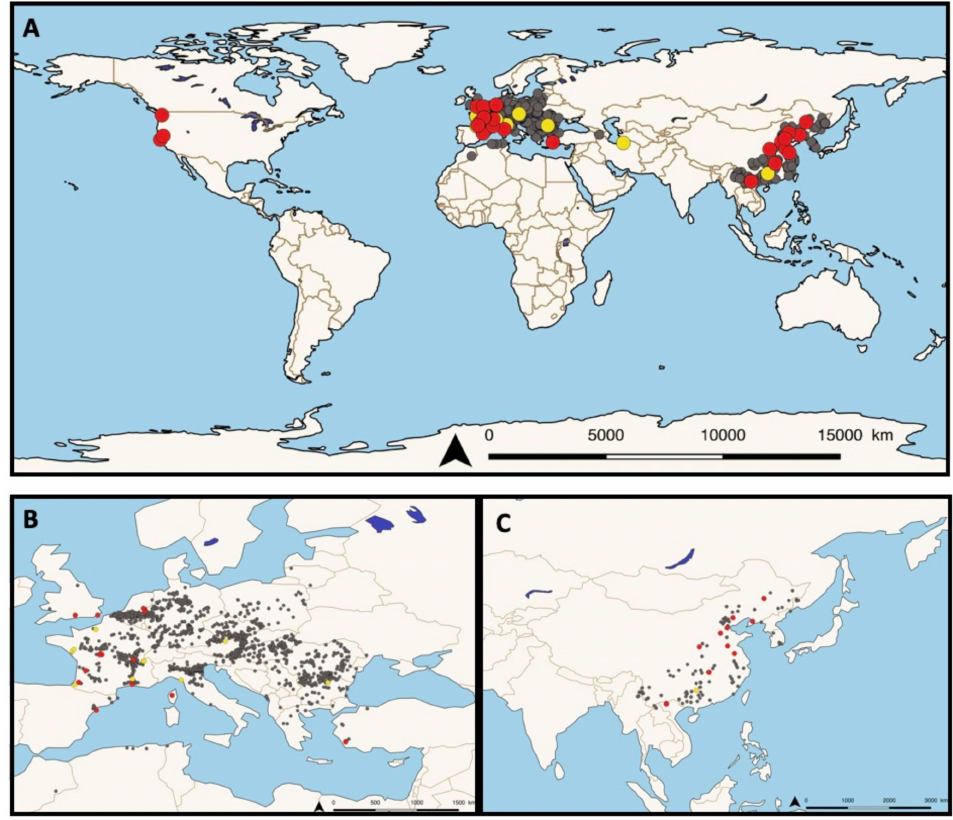
Figure 1. ( A ) Worldwide distribution of the generalist fungal parasite S. destruens . The distribution of the asymptomatic carrier host Pseudorasbora parva in its native (Est Asia) and invasive range is indicated by grey dots. The red and yellow dots indicate the distribution of P. parva and other native species tested for the presence of the agent rosette Sphareothecum destruens DNA; Red dots indicate populations found to be positive to S. destruens DNA and yellow dots indicate non-conclusive results. ( B ) Invasive distribution and ( C ) native (China) and invasive Vietnam distribution in